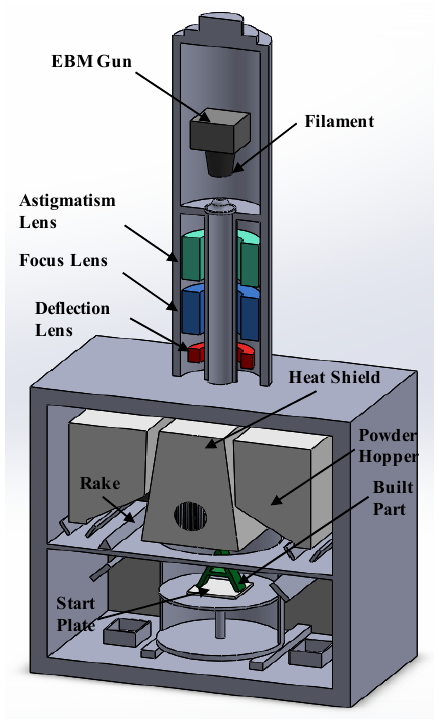
Figure 1. Schematic of an Arcam A2XX EBM machine.